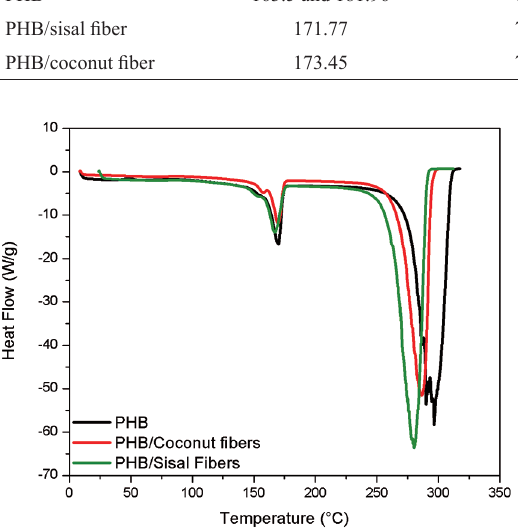
Figure 5: DSC curves up to 325 °C of PHB post-molding and composites PHB/coconut fibers and PHB/sisal fibers